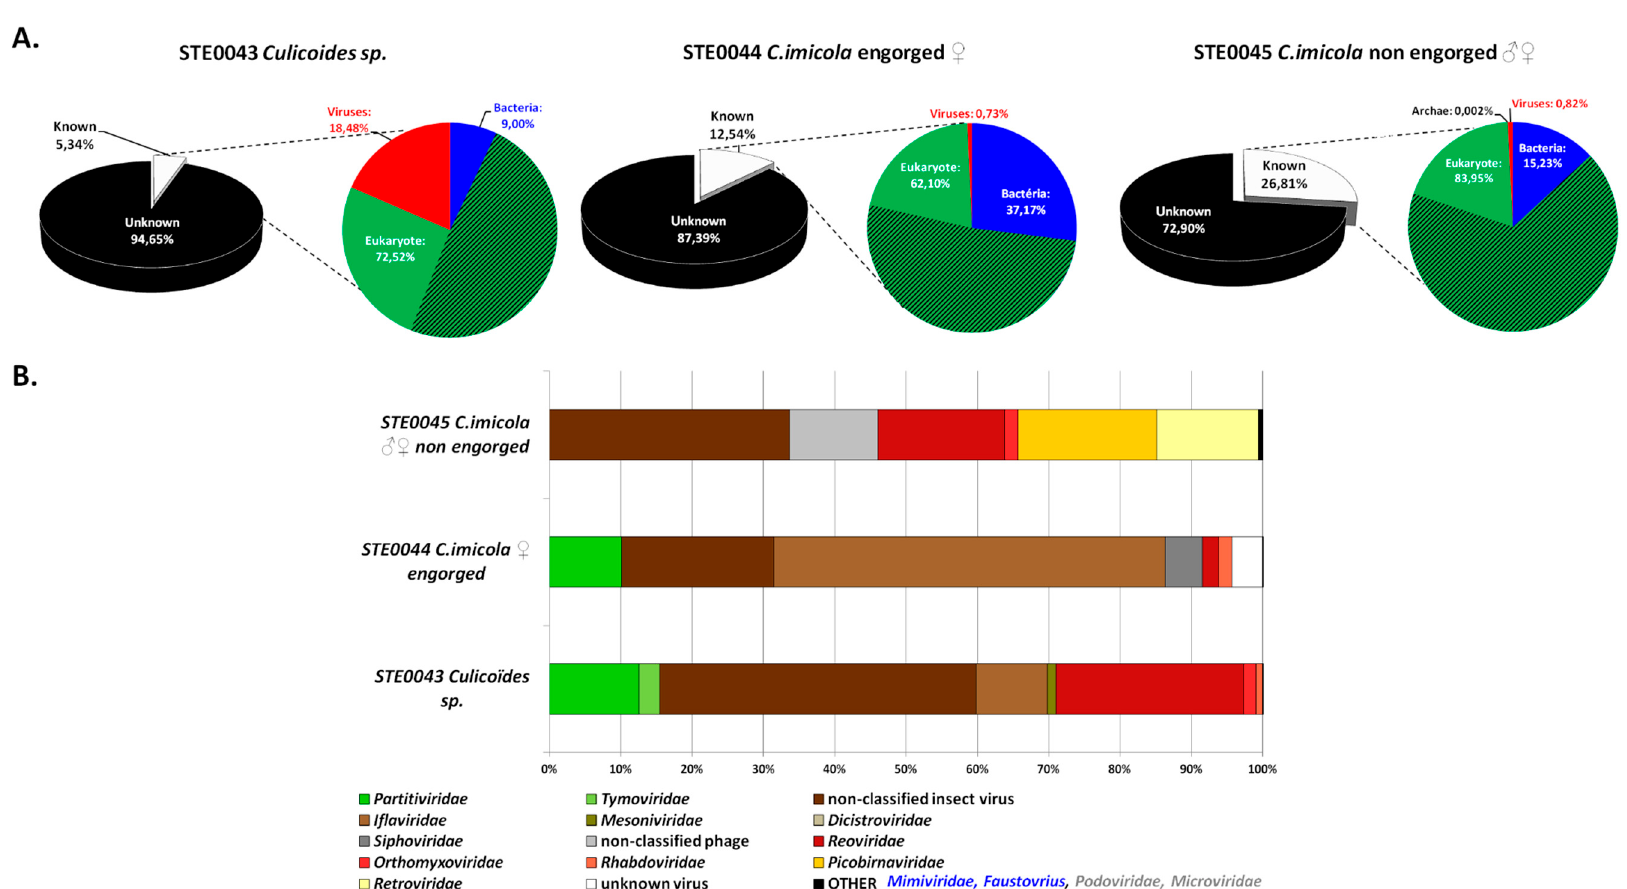
Figure 1. Taxonomic assignment of reads ( A ) BlastN search against the National Center for Biotechnology Information (NCBI) nucleotide database (dashes correspond to the arthropod ‐ borne proportion of eukaryotic reads) ( B ) Relative abundance of viral families in biting midge metagenomes according to their target hosts (Green: plant viruses, Brown: insect viruses, Grey: bacteriophages, Red: arboviruses, Yellow: mammalian viruses, Blue: amoeba ‐ infecting giant viruses).